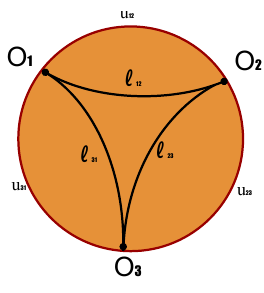
Figure 8 . Bulk Diagram for Three Point